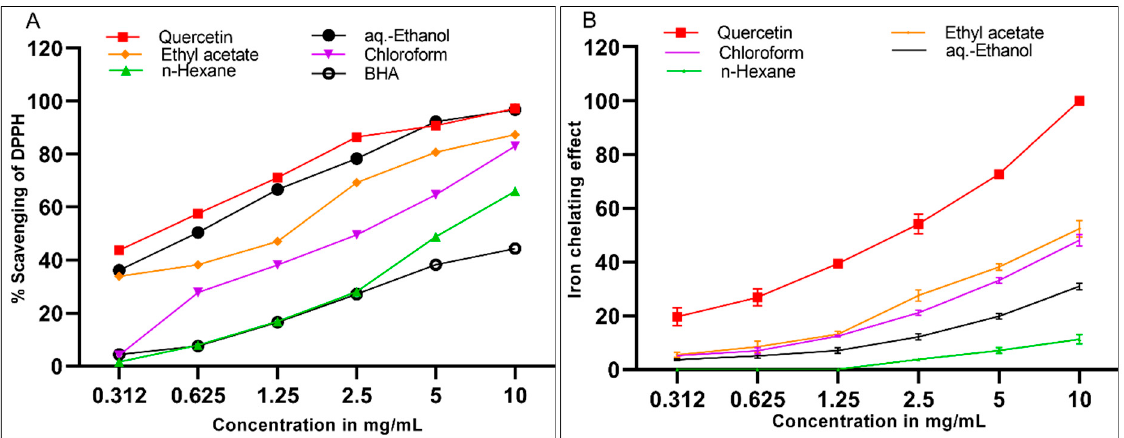
Figure 1. Anti-oxidant potentials of S. cyclophylla extracts are expressed as scavenging reactivity towards DPPH free radicals ( A ) and the iron-chelating effects ( B ). Statistical significance was performed by two-way ANOVA ( p < 0.0001). According to Tukey’s method, the extracts groups at all the measured concentrations were significantly different ( p < 0.0001) compared to quercetin in both figures A and B .